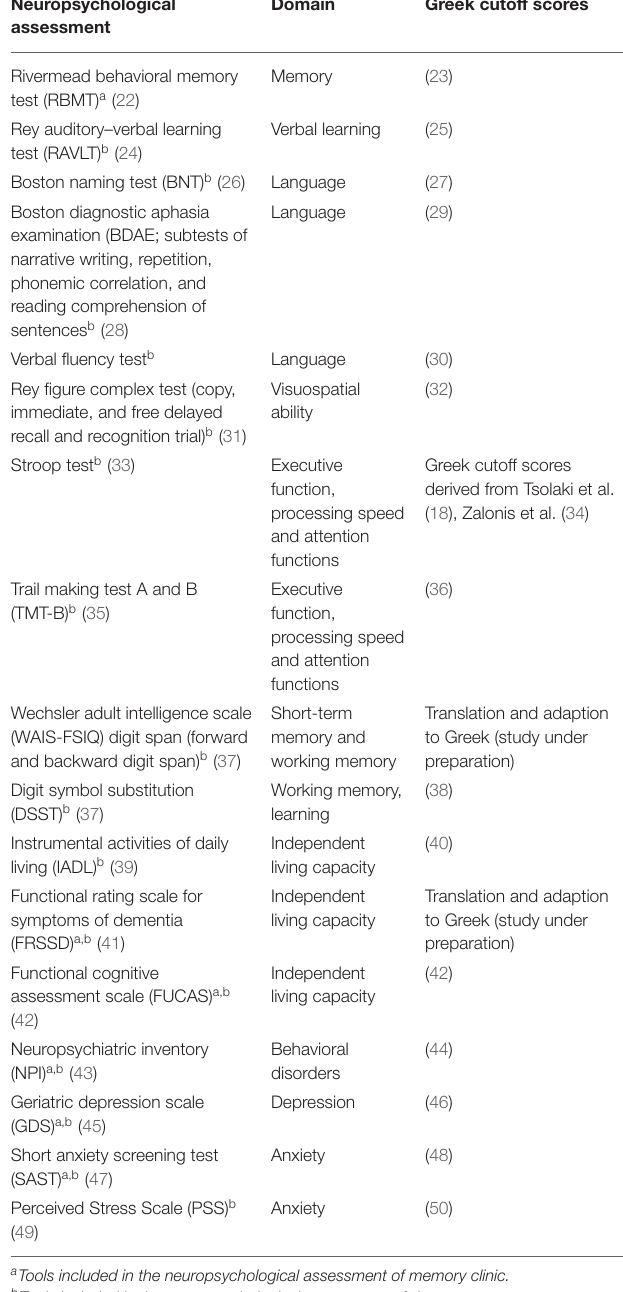
TABLE 1 | Screening tools. Screening tools